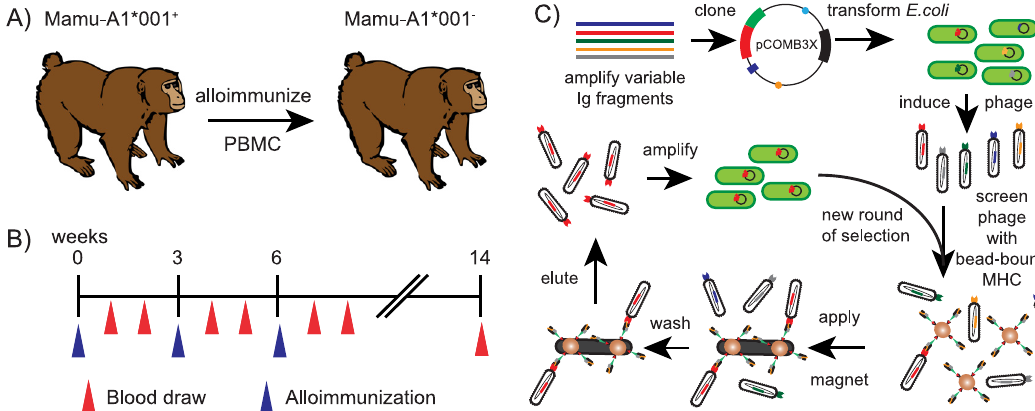
Fig 1. Overview of the antibody selection process. A) PBMC from a Mamu-A1 * 001 positive macaquewas used to alloimmunize a Mamu-A1 * 001 negativemacaqueto induce Mamu-A1 * 001-binding antibodies. B) Timeline for the immunizations and blood draws for the alloimmunized animal.C) The panningprocess to isolate the Mamu- A1 * 001-binding antibody was initiated by amplifyingimmunoglobulin genes from the alloimmunized macaqueand insertinginto the phagemid pCOMB3X. The resulting phage library was screened with biotinylated MHC moleculesbound to streptavidin-coated magneticbeadsand appliedto a magnet to wash away unboundphage.Bound phage was eluted and amplifiedin E . coli for new roundsof